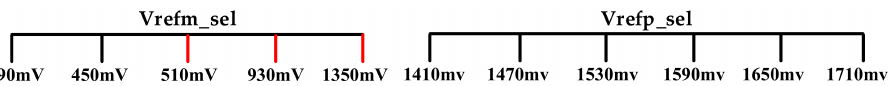
Figure 3. Two major reference voltage levels vrefm_sel and vrefp_sel.